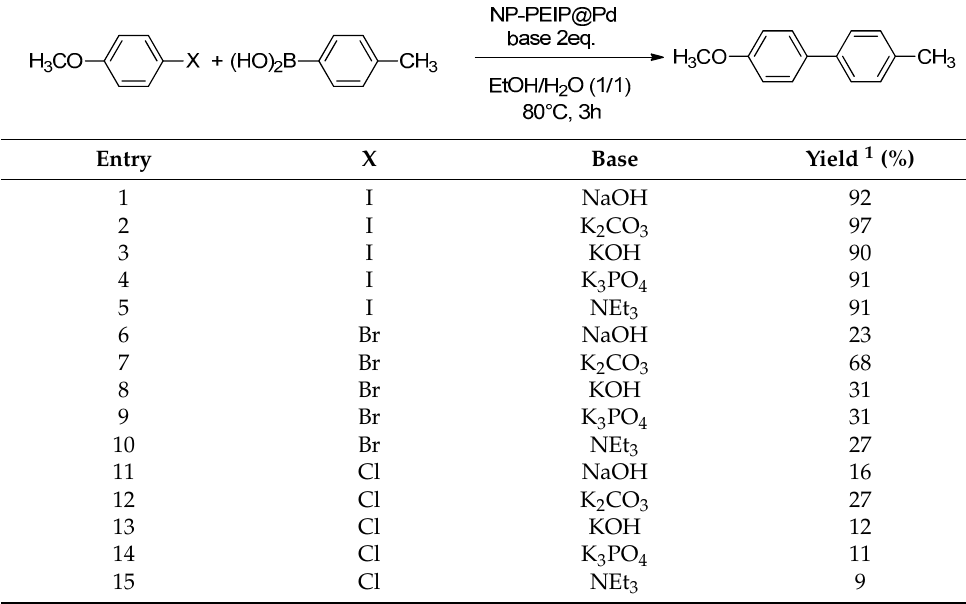
Table 1. Selection of bases for NP-PEIP@Pd catalysis.